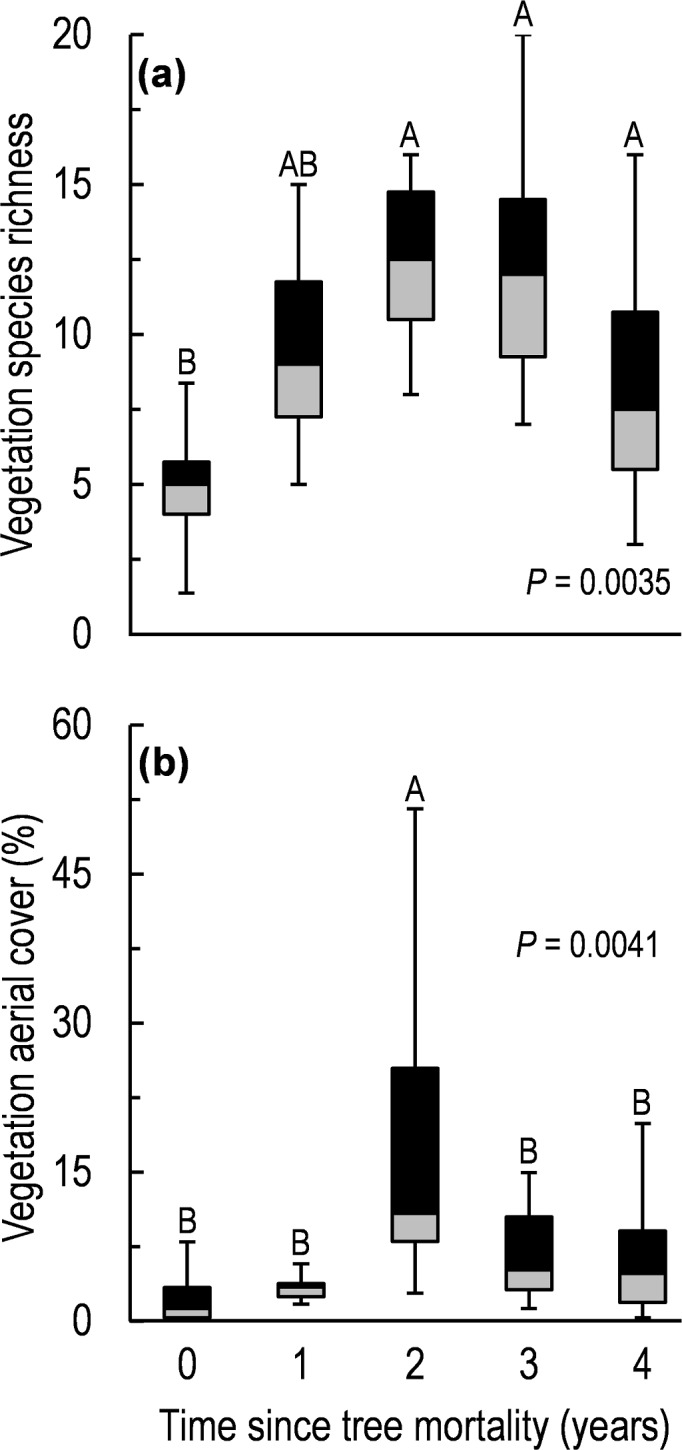
Vegetation species richness (A) and aerial cover (B) along a five-year chronosequence of insect-induced tree mortality.Box and whisker plots show the median (center line), the 1st and 3rd quartiles (shaded boxes), and the 1.5 inter-quartile range or ∼97% of variation in the untransformed data (whisker bars). Boxes with different letters are significantly different (P < 0.05) via LSD means comparisons following one-way ANOVA.